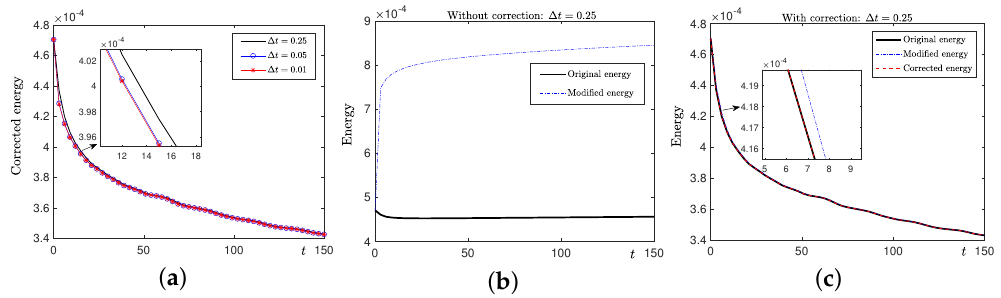
Figure 2. Evolutions of corrected energy under different time steps are shown in ( a ). With ∆ t = 0.25, the energy curves without and with correction are plotted in ( b , c ), respectively.